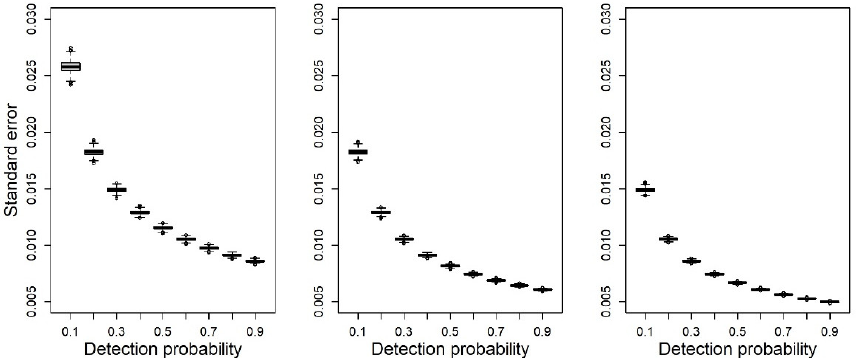
Figure 4. Results of the simulations estimating the assessment of trends in species with different detection probabilities (simulations assuming populations with stable trends). In the first row of plots, the bars represent the proportion of simulations detecting a significant (α = 0.05) decline or increase of the target species. The actual average population size of the populations ( L ) ranged from 30 to 90. The red line represents the expected type I error (0.05). In the second row, the boxplots show the distribution of the estimated trends across the 1000 simulation replicates. The red line represents the actual simulated trend. In the third row, the boxplot shows the distribution of the standard errors of the estimated trends across the 1000 replicates.